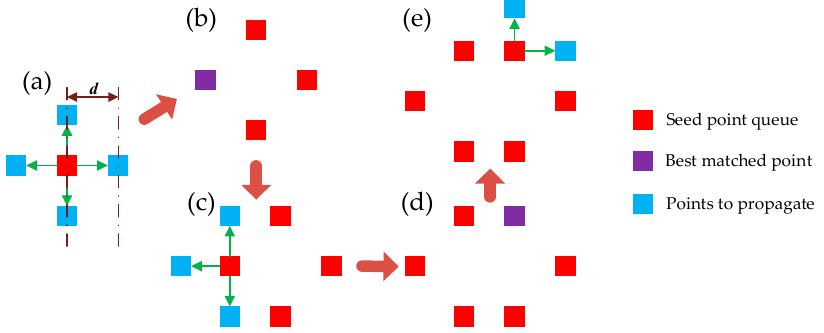
Figure 5. Optimal seed point propagation. ( a ) Propagation of the mother seed point. ( b ) Propagation result of ( a ). ( c ) Propagation of the optimal seed point in ( b ). ( d ) Propagation result of ( c ). ( e ) Propagation of the optimal seed point in ( d ).